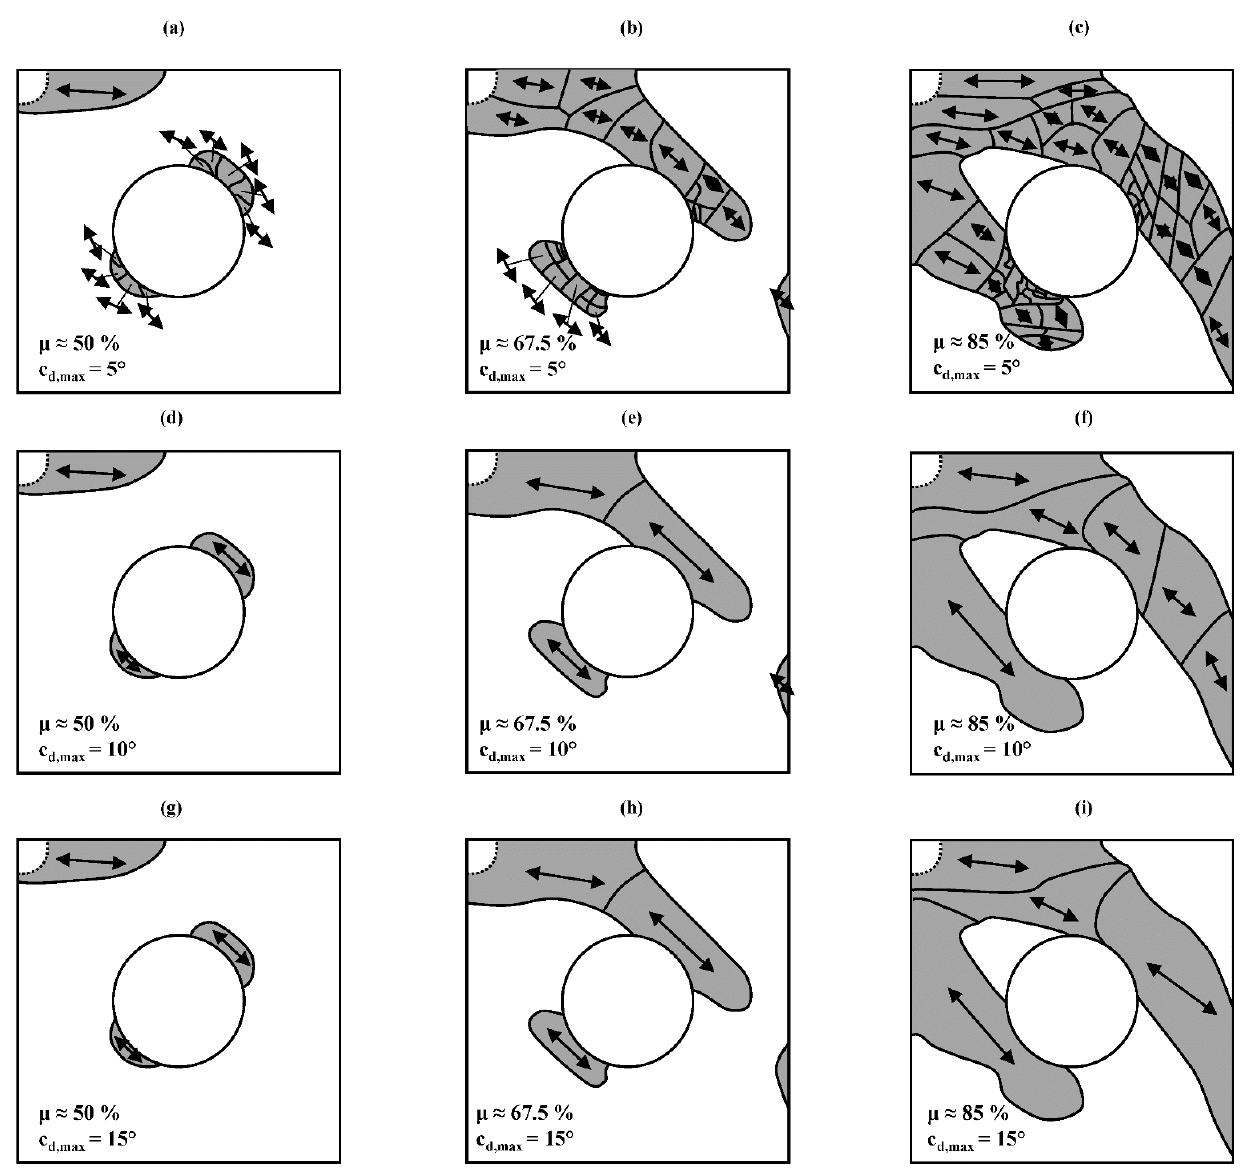
Figure 13. Illustration of the clusters and homogenized angles for the demonstration example. Results for deviation factors of c d,max = 5°, c d,max = 10°, and c d,max = 15° for stress thresholds μ = 50%, μ = 67.5%, and μ = 85% are shown in ( a )–( i ). Grey areas indicate reinforcement areas. Angles for small clusters in ( b , c ) are not displayed.